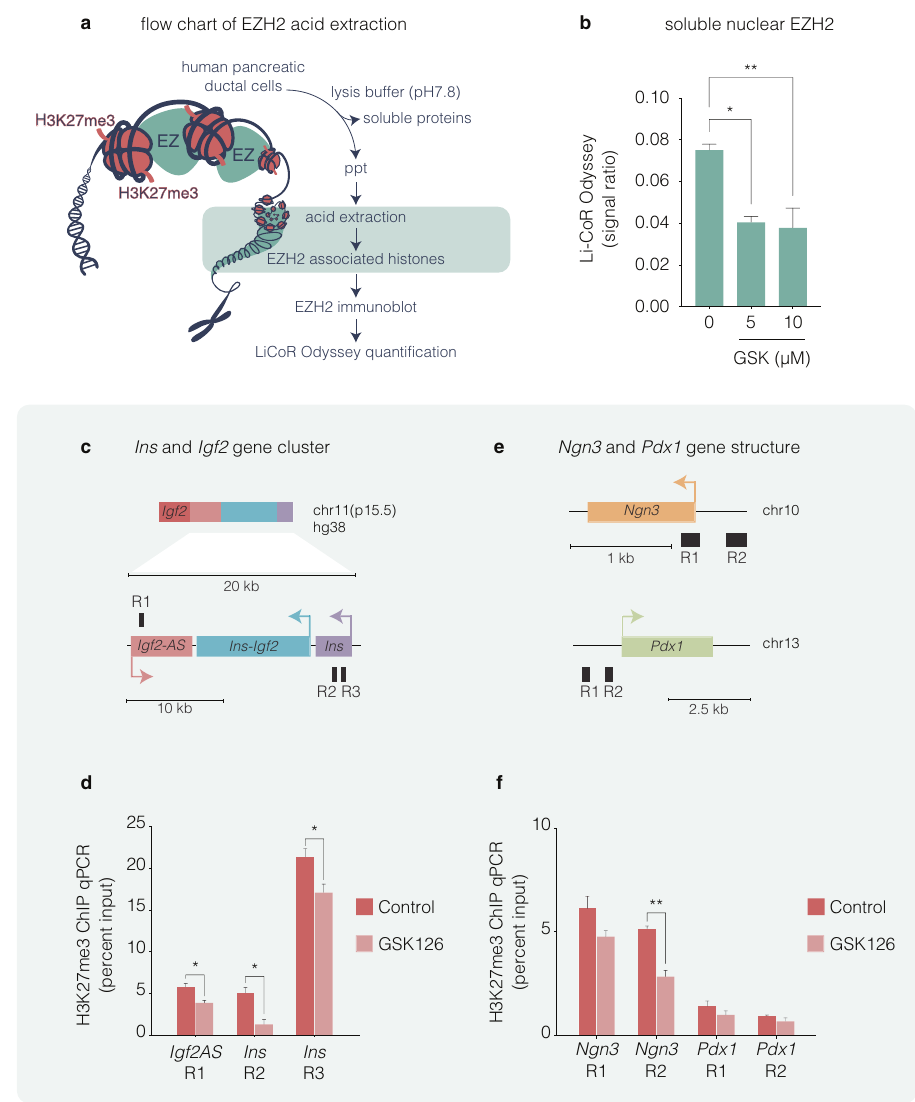
Fig. 5 GSK126 in fl uences the refractory H3K27me3 content on the insulin chromatin domain in human non-diabetic exocrine cells. a Flow chart of EZH2 acid extraction from human pancreatic ductal cells. Puri fi cation method of acid histone-associated protein fraction isolated from heterochromatin isolates derived from pancreatic ductal nuclei. Extraction of histone-binding EZH2 protein fraction from heterochromatin involve acid homogenisation and precipitation (ppt) with 5 M H 2 SO 4 . Isolated histone-binding proteins with EZH2 were fractionated and quanti fi ed using Li-COR Odyssey. b Dose-dependent increase of GSK126 (5 or 10 µM) for 48 h attenuates EZH2 in human pancreatic ductal cells. Quanti fi cation levels of EZH2 were calculated and adjusted to unmodi fi ed histone H3 using Li-COR Odyssey. The signal ratio was calculated as EZH2/overall H3. Vehicle control was DMSO. Ordinary one-way ANOVA was performed on Control vs GSK-126 (* P < 0.05, ** P < 0.01, error bars are SEM, n = 3). c Insulin domain was assessed using amplimers that were speci fi cally designed to distinguish promoter regions (R) of the Ins and Igf2AS genes. d Quantitative PCR analysis of DNA in chromatin immunoprecipitated (ChIP) with anti-H3K27me3 antibody. Vehicle control was DMSO. e DNA was assessed using amplimers that speci fi cally recognise the promoter regions (R) of the Ngn3 and Pdx1 genes. f Quantitative PCR analysis of DNA in ChIP with anti-H3K27me3 antibody. Vehicle control was DMSO. Data represented as the mean Input signal against speci fi c H3K27me3 abundance. Student ’ s t -test was performed on Control vs GSK-126 (* P < 0.05, ** P < 0.01 error bars are SEM, n =